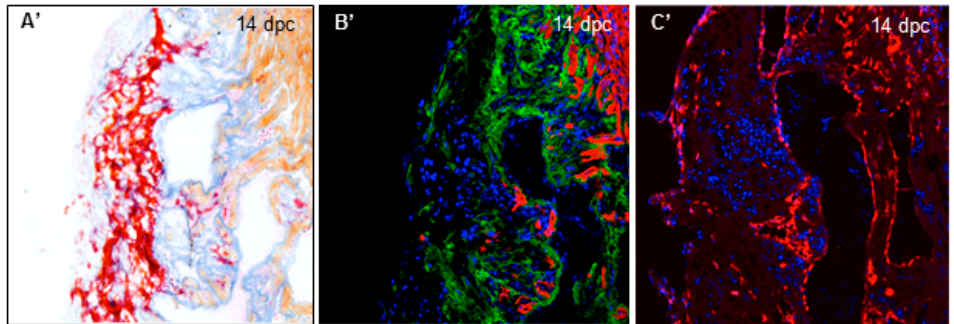
Figure 1. Collagenolytic activity and fibroblast activation during heart regeneration. ( A ) Wound area visualized with AFOG staining of frozen sections from uninjured hearts ( n = 3) or hearts at 14 dpc ( n = 7), 30 dpc ( n = 8) and 60 dpc ( n = 6) (fibrin in red, collagen in blue, and counterstaining in orange). ( B ) Confocal imaging of consecutive sections from hearts stained in (A). Green fluorescence represents the release of fluorescein activity due to the degradation of DQ-collagen substrate. Tropomyosin immunostaining is used as counterstaining (red fluorescence). ( C ) col1a1a expression by fluorescent in situ hybridization on consecutive sections from the same hearts shown in A and B. col1a1a mRNA in red, nuclei in blue (DAPI). Comparison of collagenolytic activity ( B’ ) and fibroblasts ( C’ ) with collagen ( A’ ) on consecutive sections of the 14 dpc heart at a 20× magnification (magnification of the boxes in ( A – C ) respectively). Dashed lines represent the wound area.